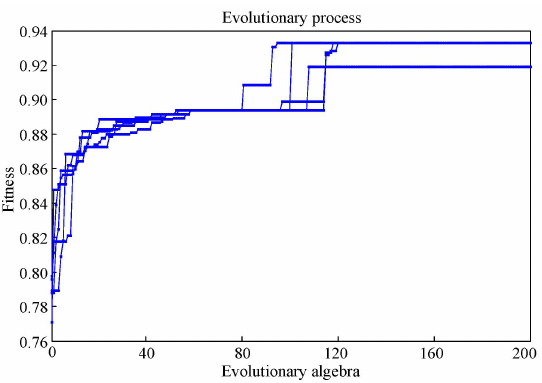
Figure 16. Convergence procedure of the DSPSO under fault scenario